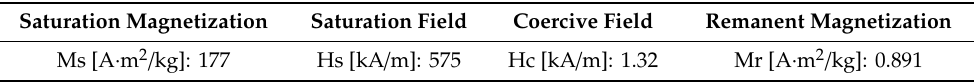
Figure 8. Magnetization curve and hysteresis loops measuring micro-sized (4–6 µ m, Carl Roth GmbH, Karlsruhe, Germany) Fe particles in a powdered state. The hysteresis loops presented in the figure are smooth with no hysteresis, which indicates a soft magnetic material with coercive force, and the residual magnetization approaches zero. Table 4. Fe particle magnetic properties (particles size of 4–6 µ m). Saturation